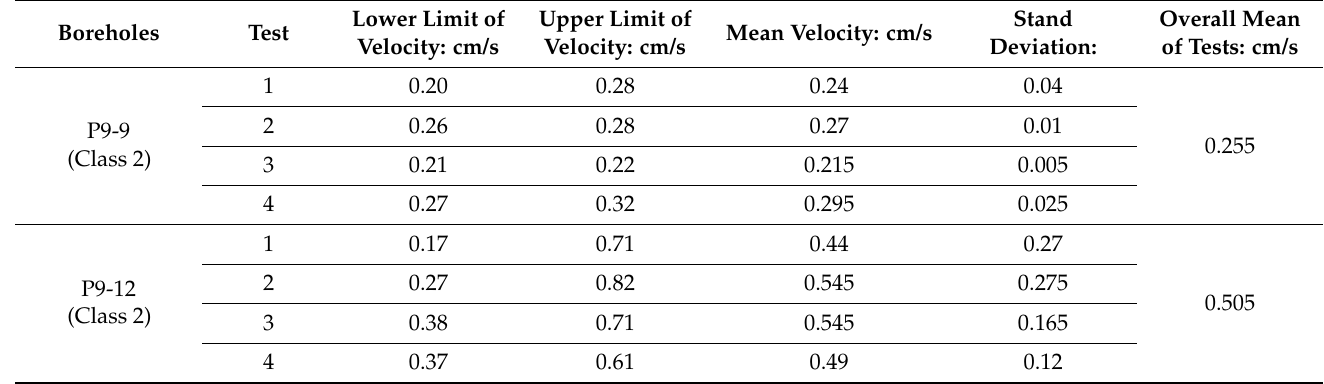
Table 2. The effective vertical velocity of P9-9 and P9-12 calculated using Equation